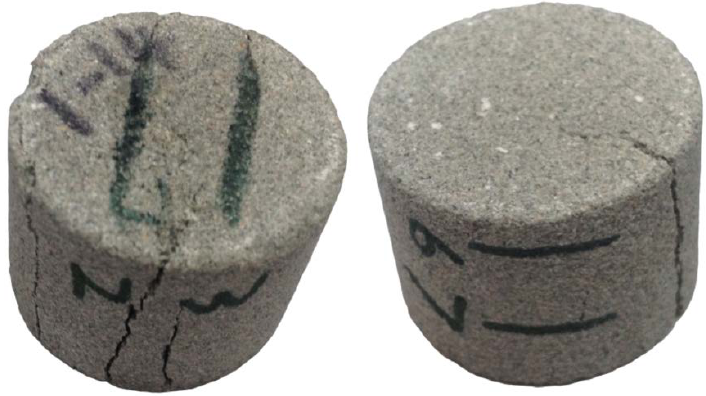
Figure 14. Samples after the impact tests. Even though the sample number for the intermediate strain rate tests is very small, the thin sections for the different directions were obtained from different samples. The thin sections were obtained along the green line.